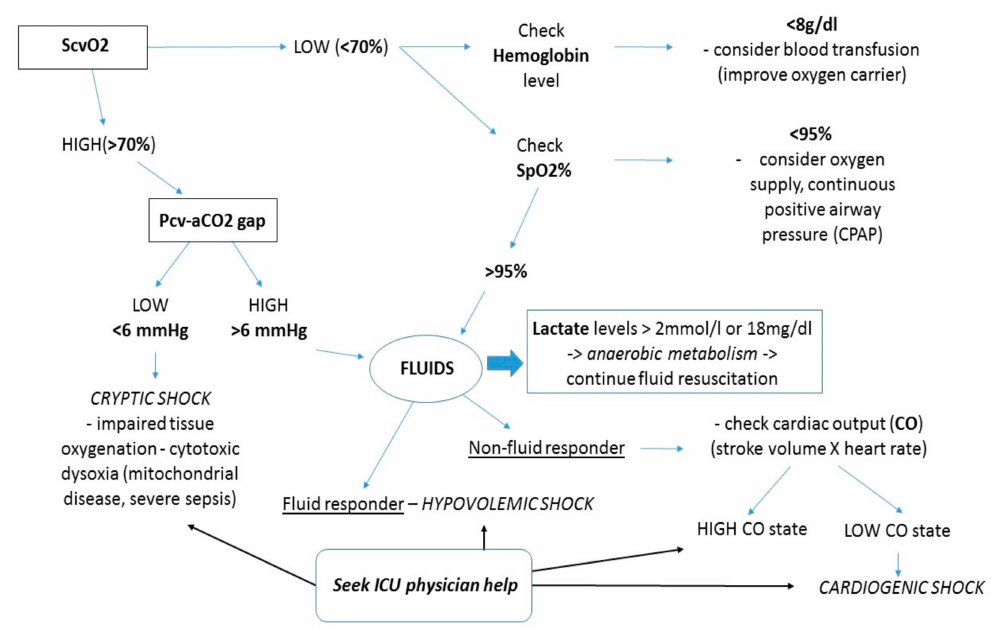
Figure 2. Clinical interpretation of ScvO 2 and Pcv–aCO 2